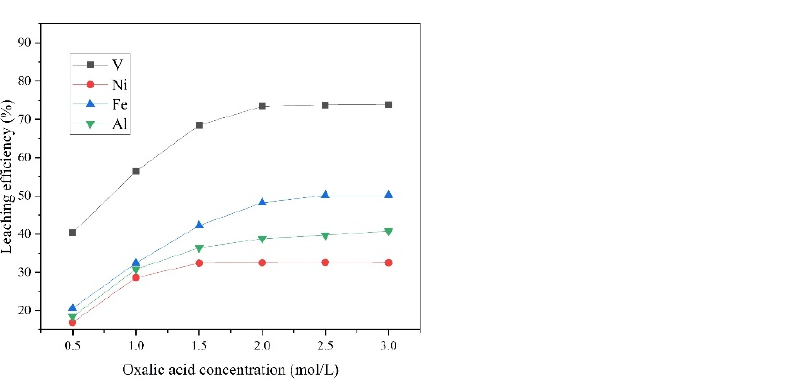
Figure 6. Effects of oxalic acid concentration on leaching efficiencies of metals (t = 240 min; T = 95 °C ; D50 ≤ 17.34 μ